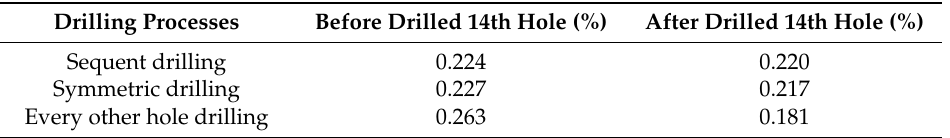
Figure 21. Deformation varying with amount of drilling. Table 4. Variations in deformation and strain energy with different drilling processes. Table 5. The average reduction in relative strain energy between the drilling holes.